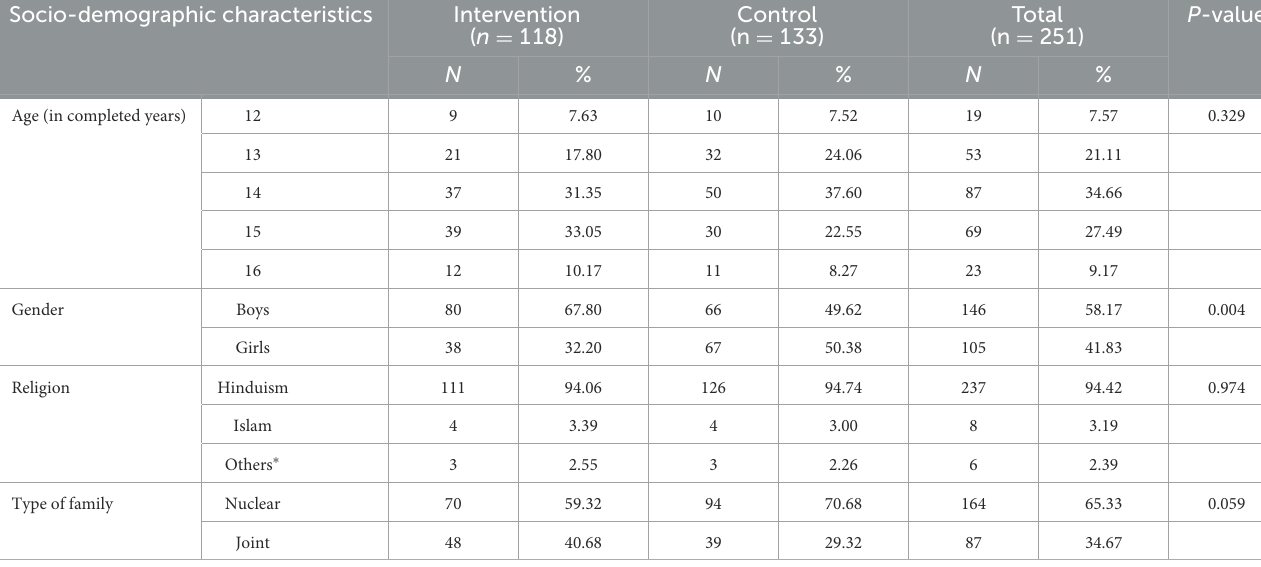
TABLE 1 Socio-demographic characteristics of the participants. Socio-demographic characteristics